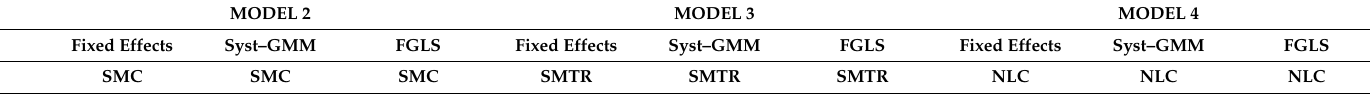
Table 6. Panel regression results on the estimation of the ICT-stock market development